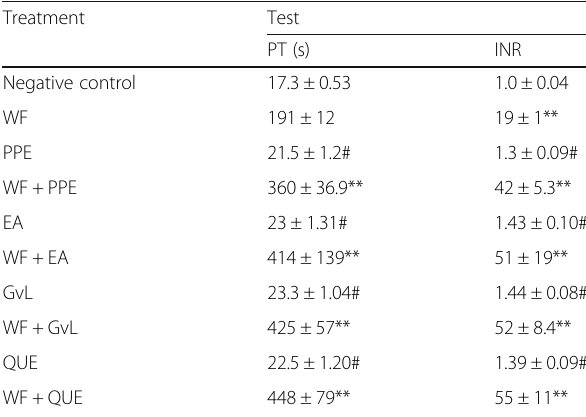
Table 2 Prothrombin time (PT) and International Normalized Ratio (INR) measurements of different rat groups treated with the natural products and their quality markers alone or in combination with warfarin